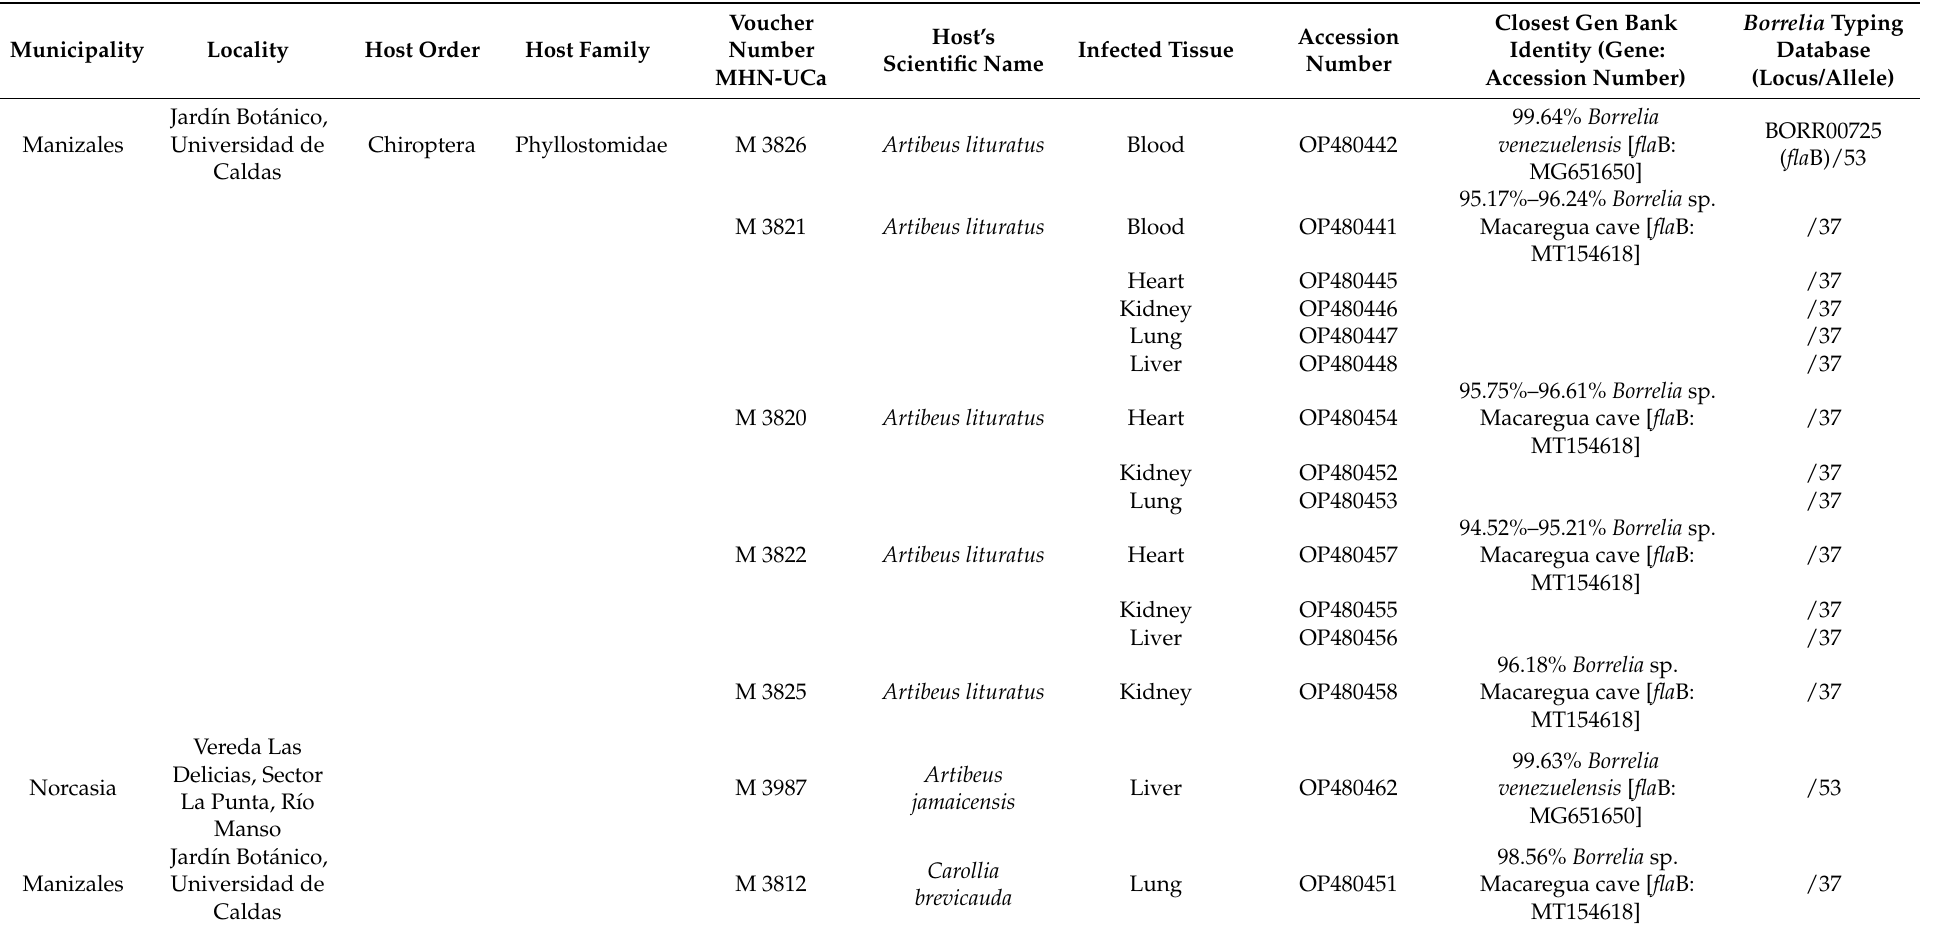
Table 1. Mammals infected with Borrelia sp. in the departments of Caldas and Risaralda, Colombia. MHN-UCa-M: mammal collection, Museo de Historia Natural, Universidad de